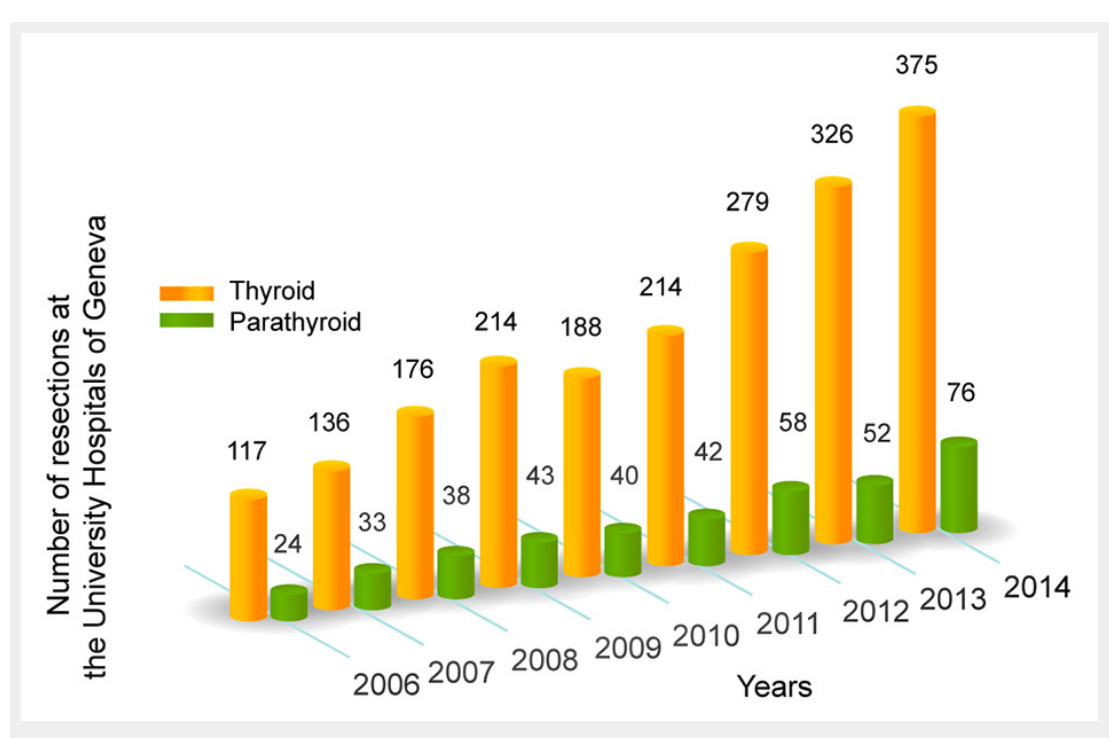
Figure 1 Number of operations on the thyroid and parathyroid glands performed in our centre during the last 8 years.